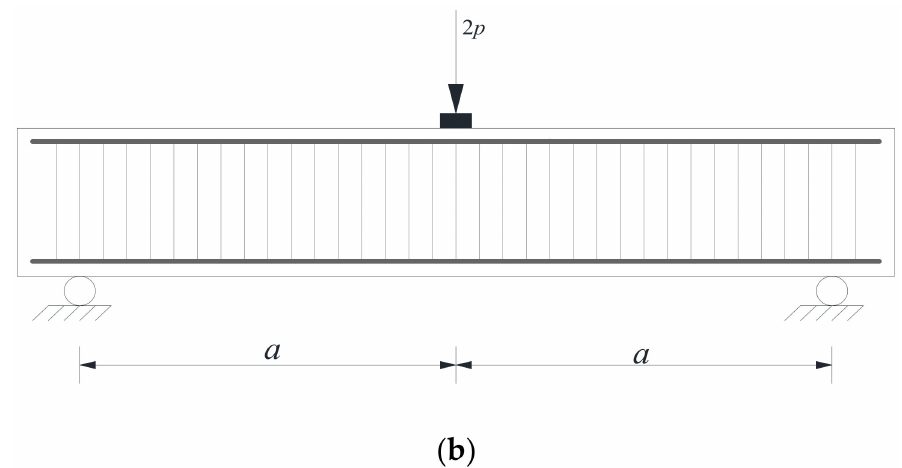
Figure 1. Shear loading tests of beams: ( a ) four-point loading setup; ( b ) three-point loading setup.